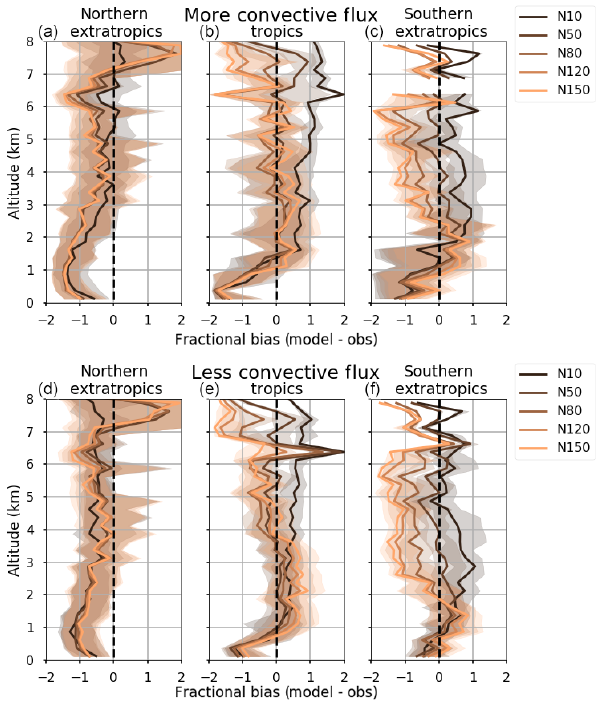
Figure 10. The vertical profile of fractional bias in modelled aerosol number at different size cut-offs for measurements in the north- ern extratropics (a) , the tropics (b) and the southern extratropics (c) with increased (by a factor of 2.0) and decreased (by a factor of 0.5) coagulation